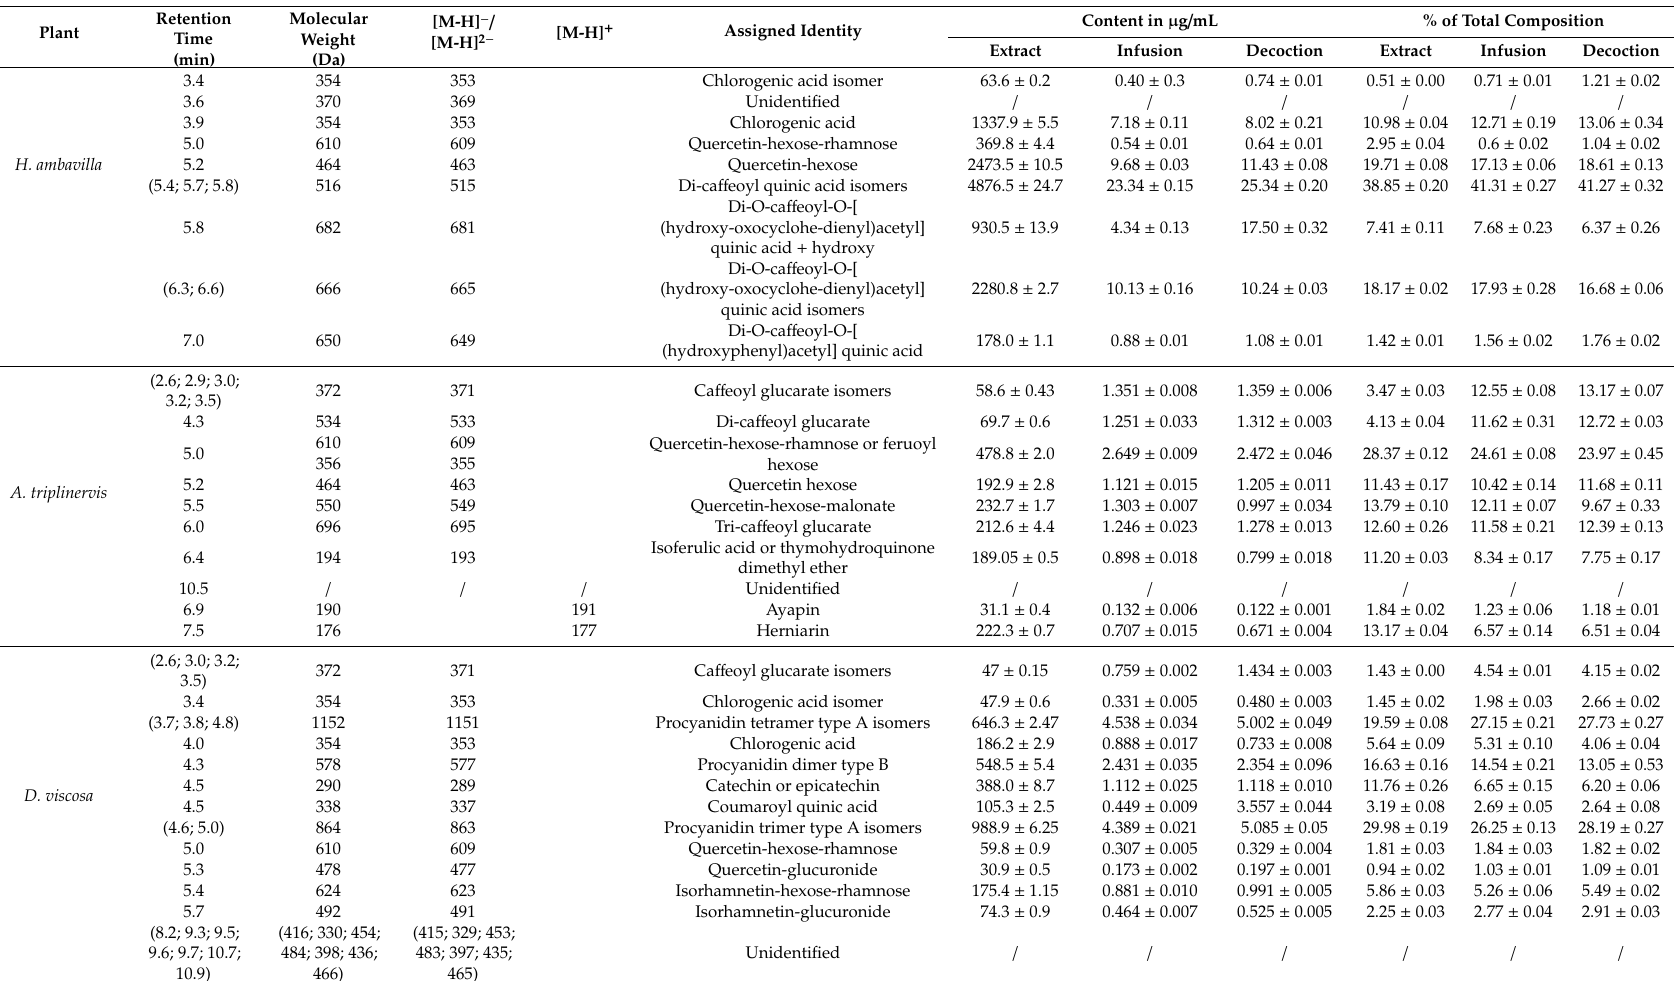
Table 2. UPLC-MS / MS analysis of the polyphenol content of medicinal plant PRE, infusions and decoctions.